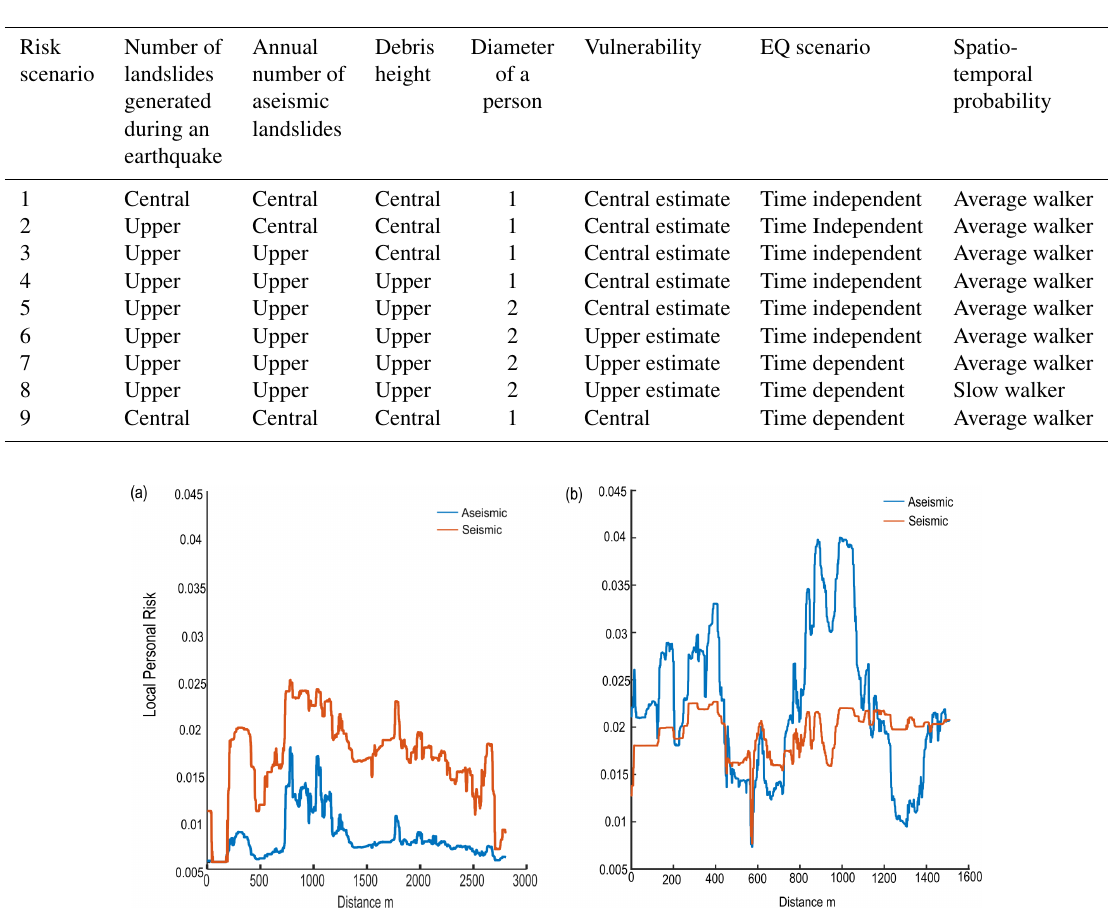
Table 2. Risk model scenarios and associated input variables.